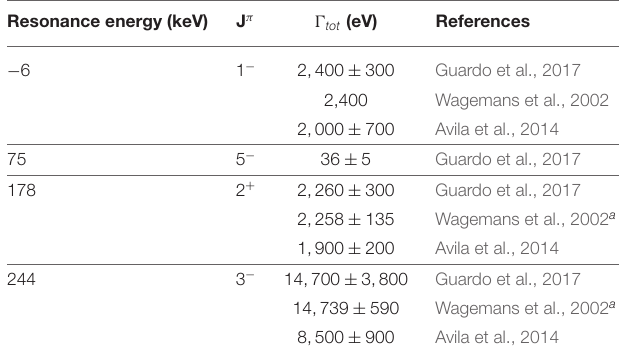
TABLE 6 | Summary table of the 18 O resonance parameters observed in Guardo et al. (2017). Resonance energy (keV)